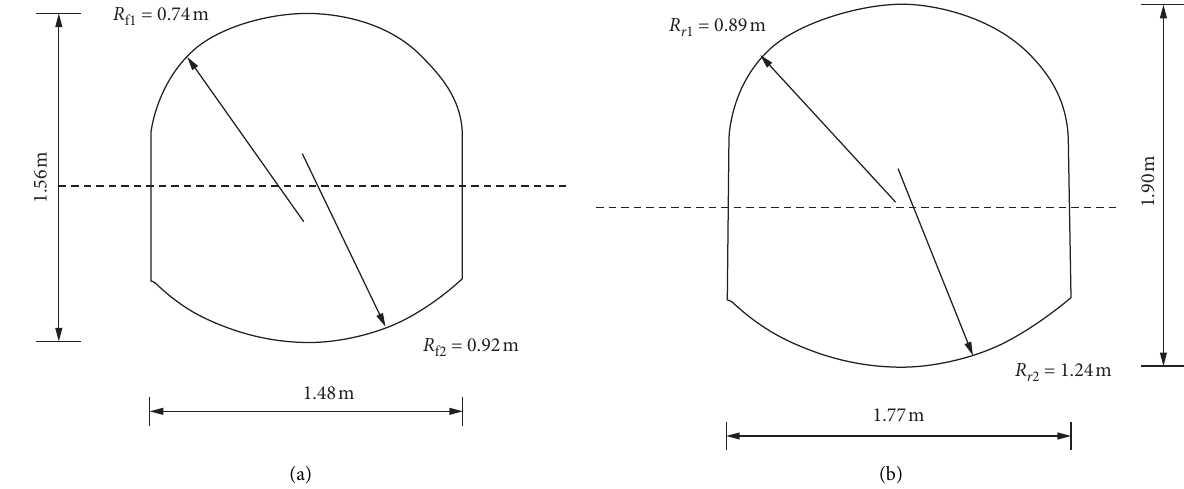
Figure 6: (a) Front-side surface and (b) rear-side surface of a single model anchor.